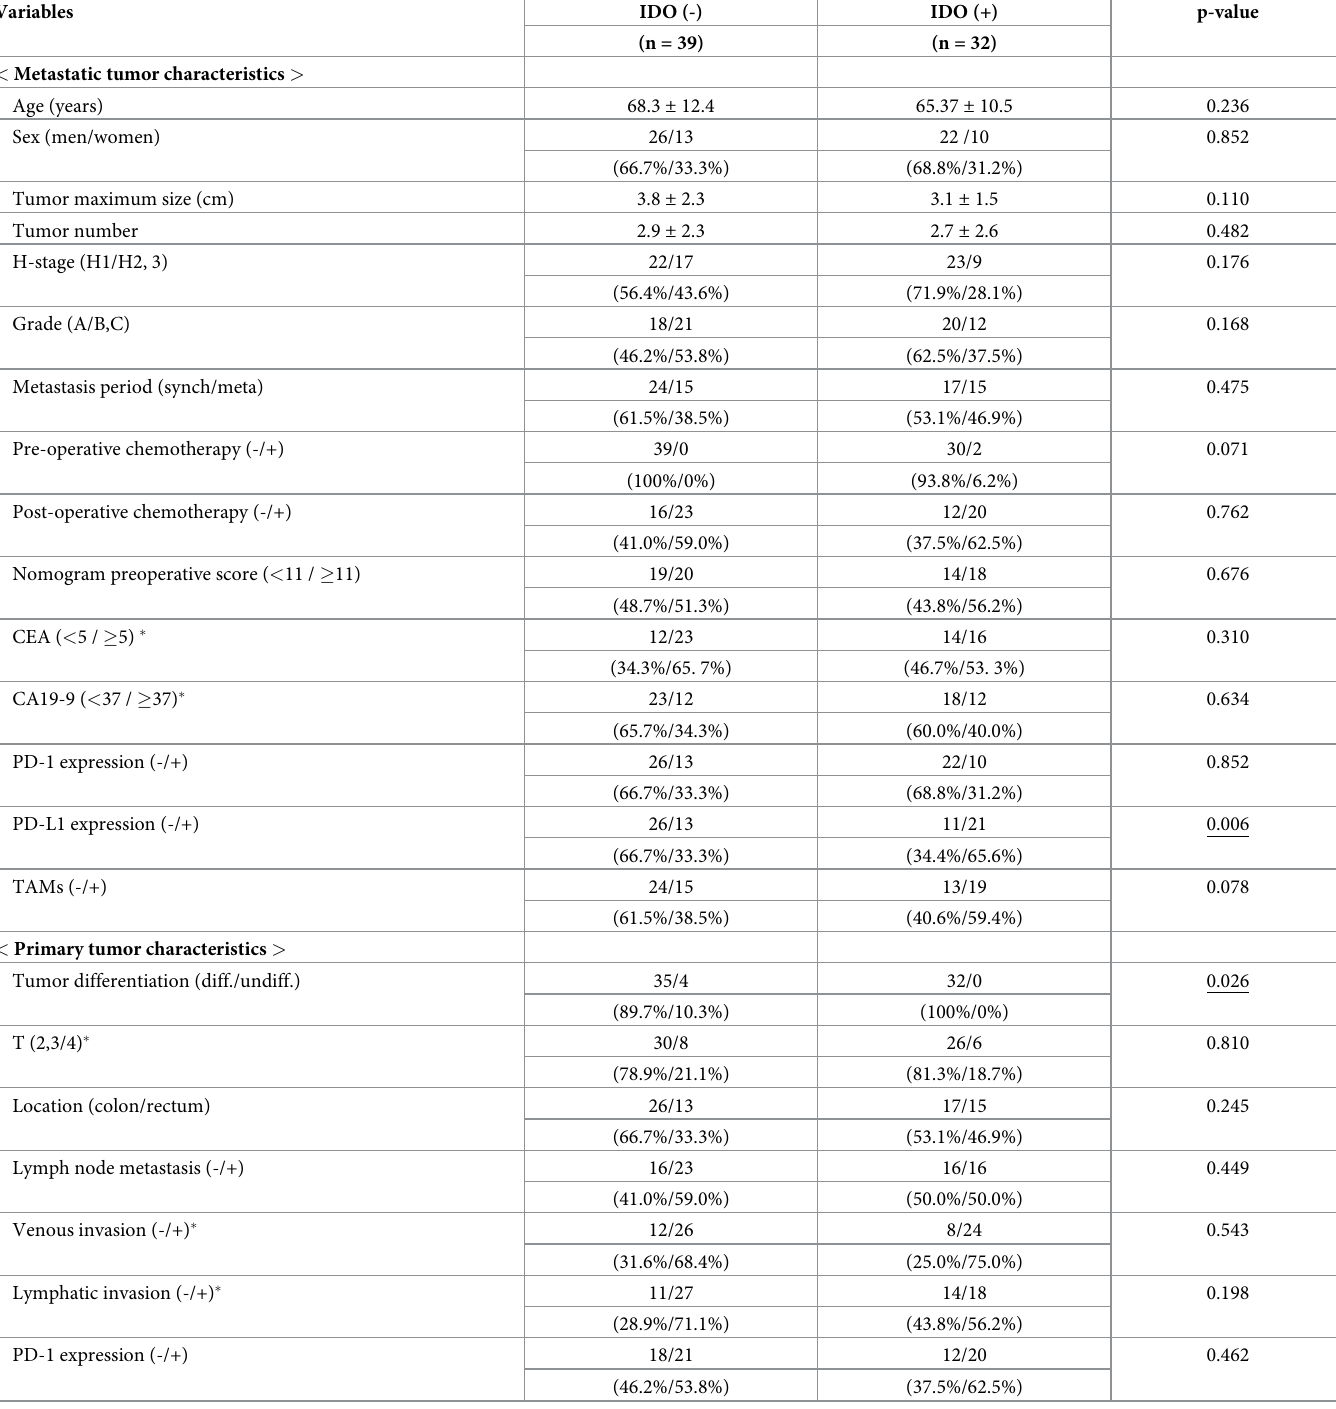
Table 3. Patients’ clinicopathological characteristics according to IDO